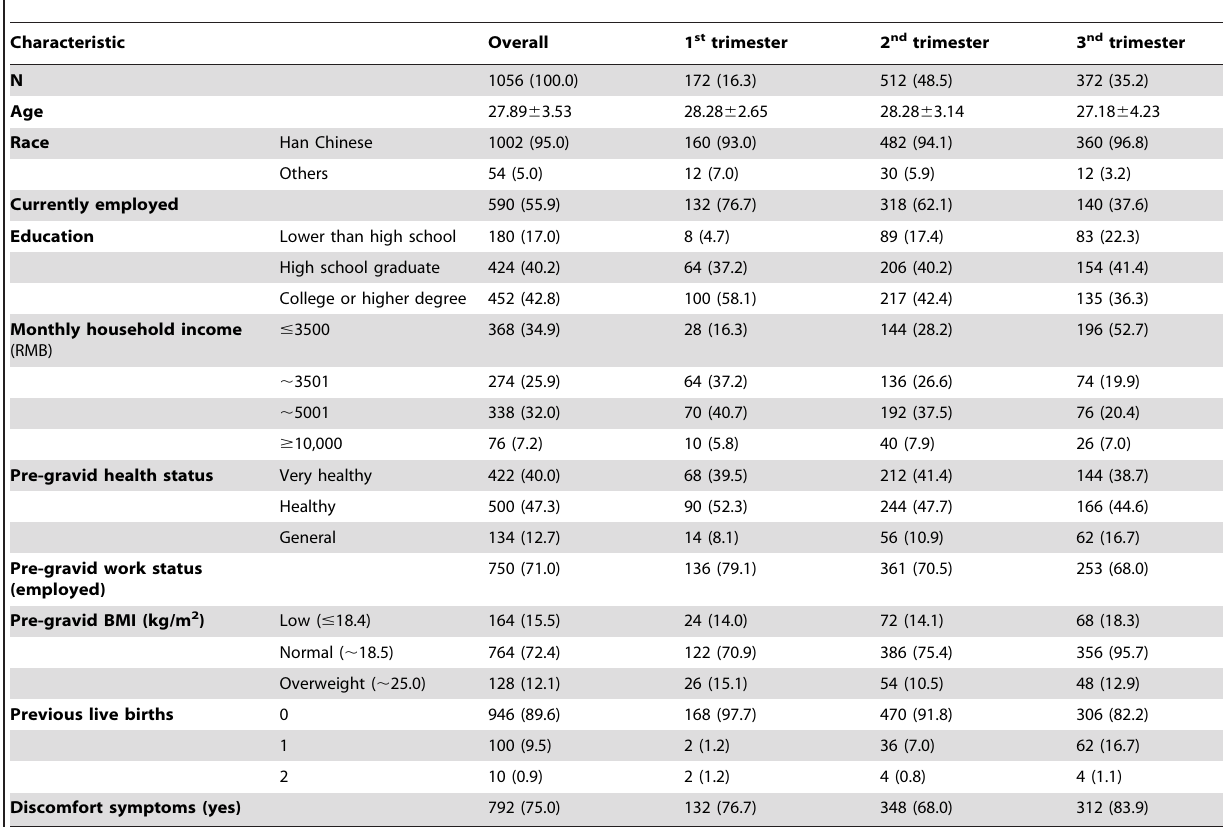
Table 1. Socio-demographic of pregnant women n